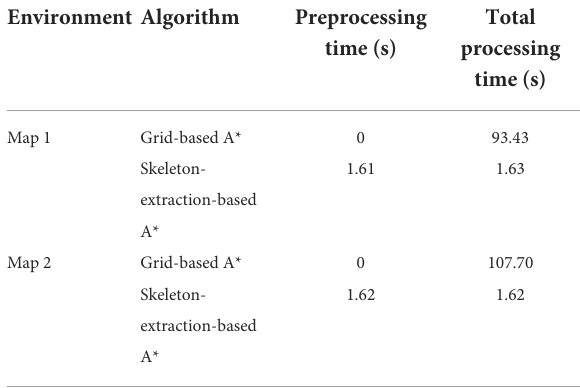
TABLE 1 Path planning